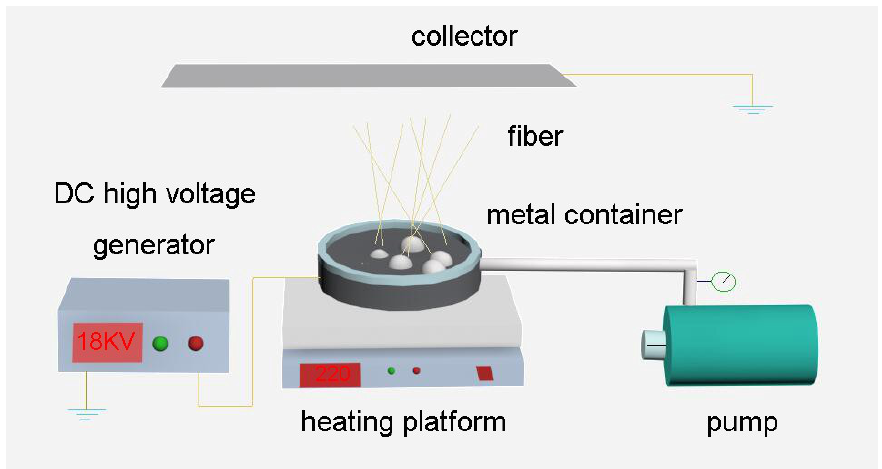
Figure 1. Schematic drawing of the bubble melt e-spinning setup.